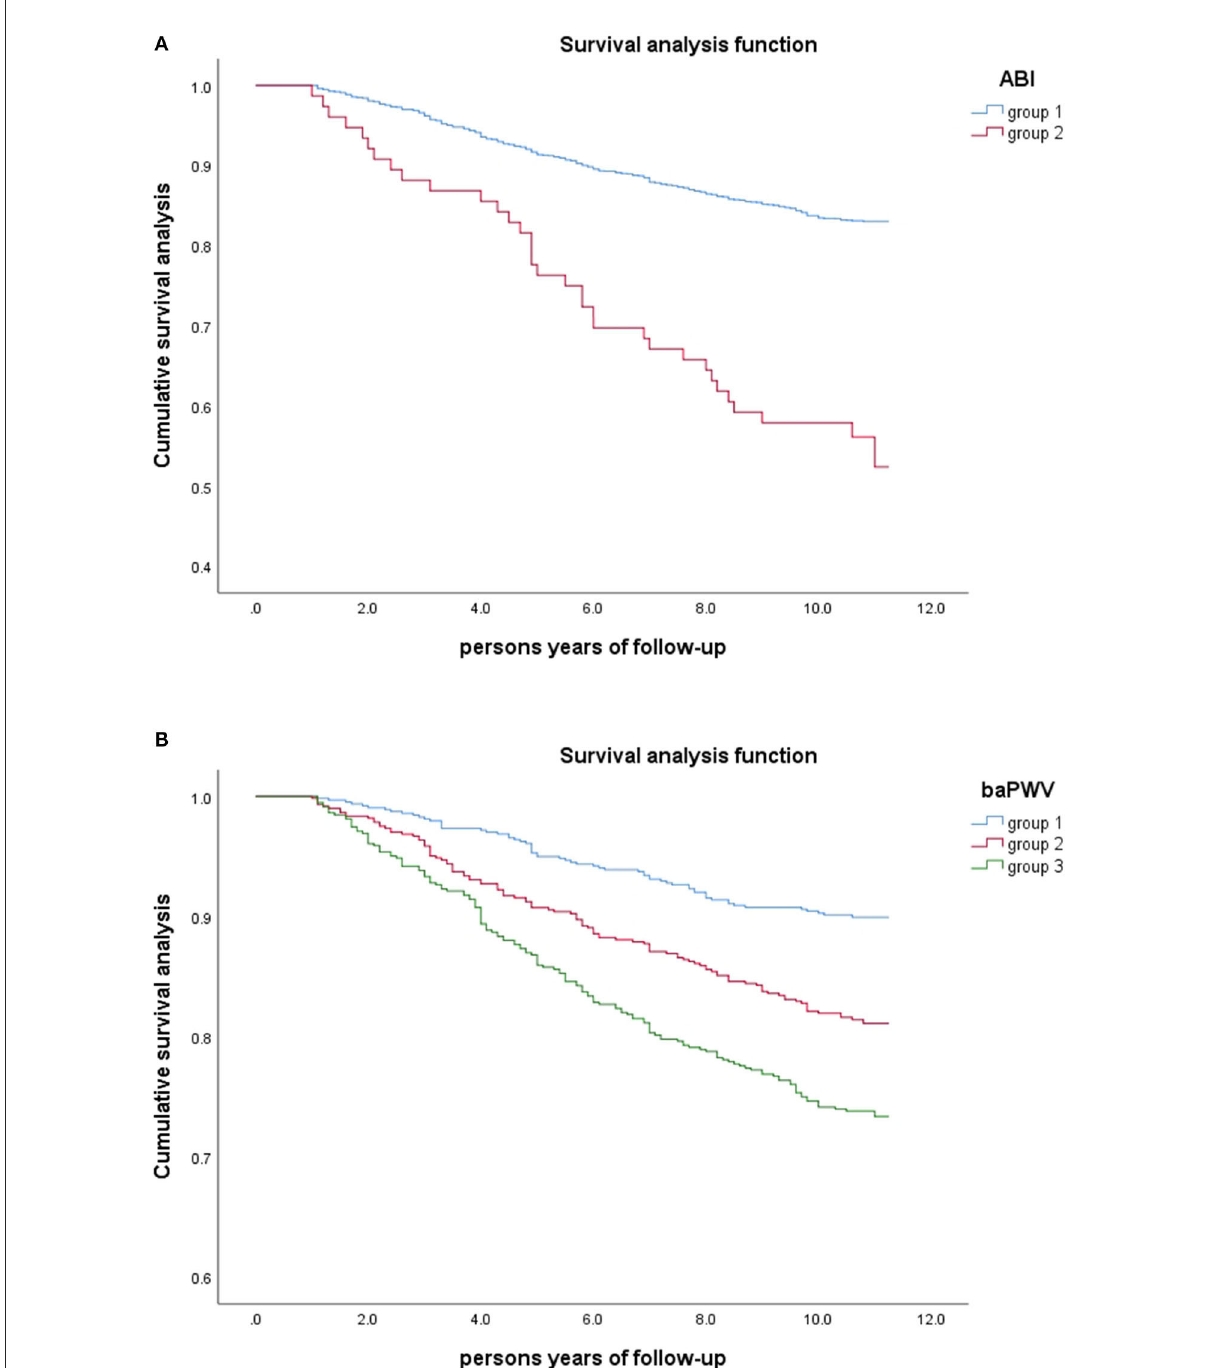
FIGURE4 Kaplan-Meier Survival Curves in Different Groups of Study Population ( n = 1826). (A) Grouped by ABI(group 1: 0.9 < ABI ≤ 1.3; group 2: ABI ≤ 0.9). (B) Grouped by baPWV (group1: baPWV < 1761.5cm/s; group2: 1761.5 ≤ baPWV < 2121.5cm/s; group3: baPWV ≥ 2121.5cm/s).